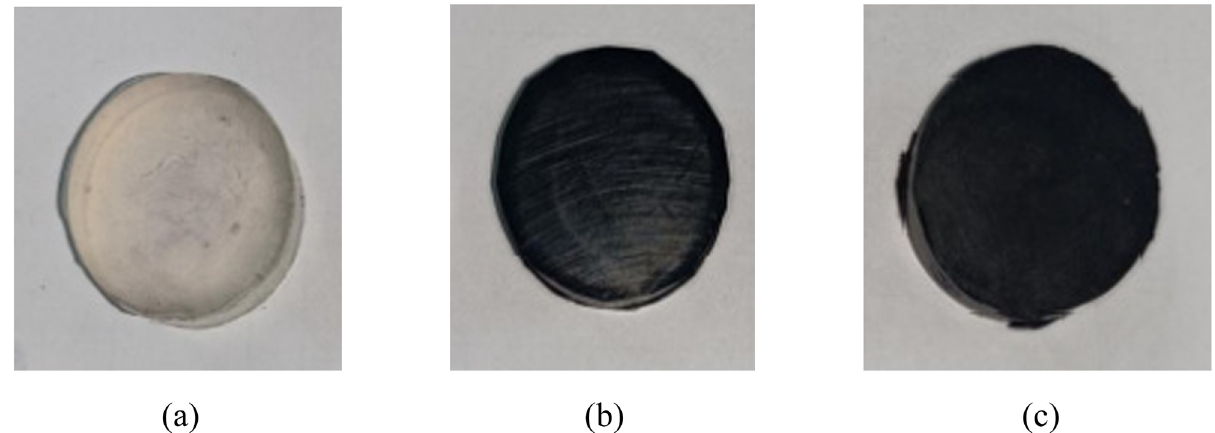
Figure 1: Rubber samples of ( a ) LSR, ( b ) EPDM, and ( c )